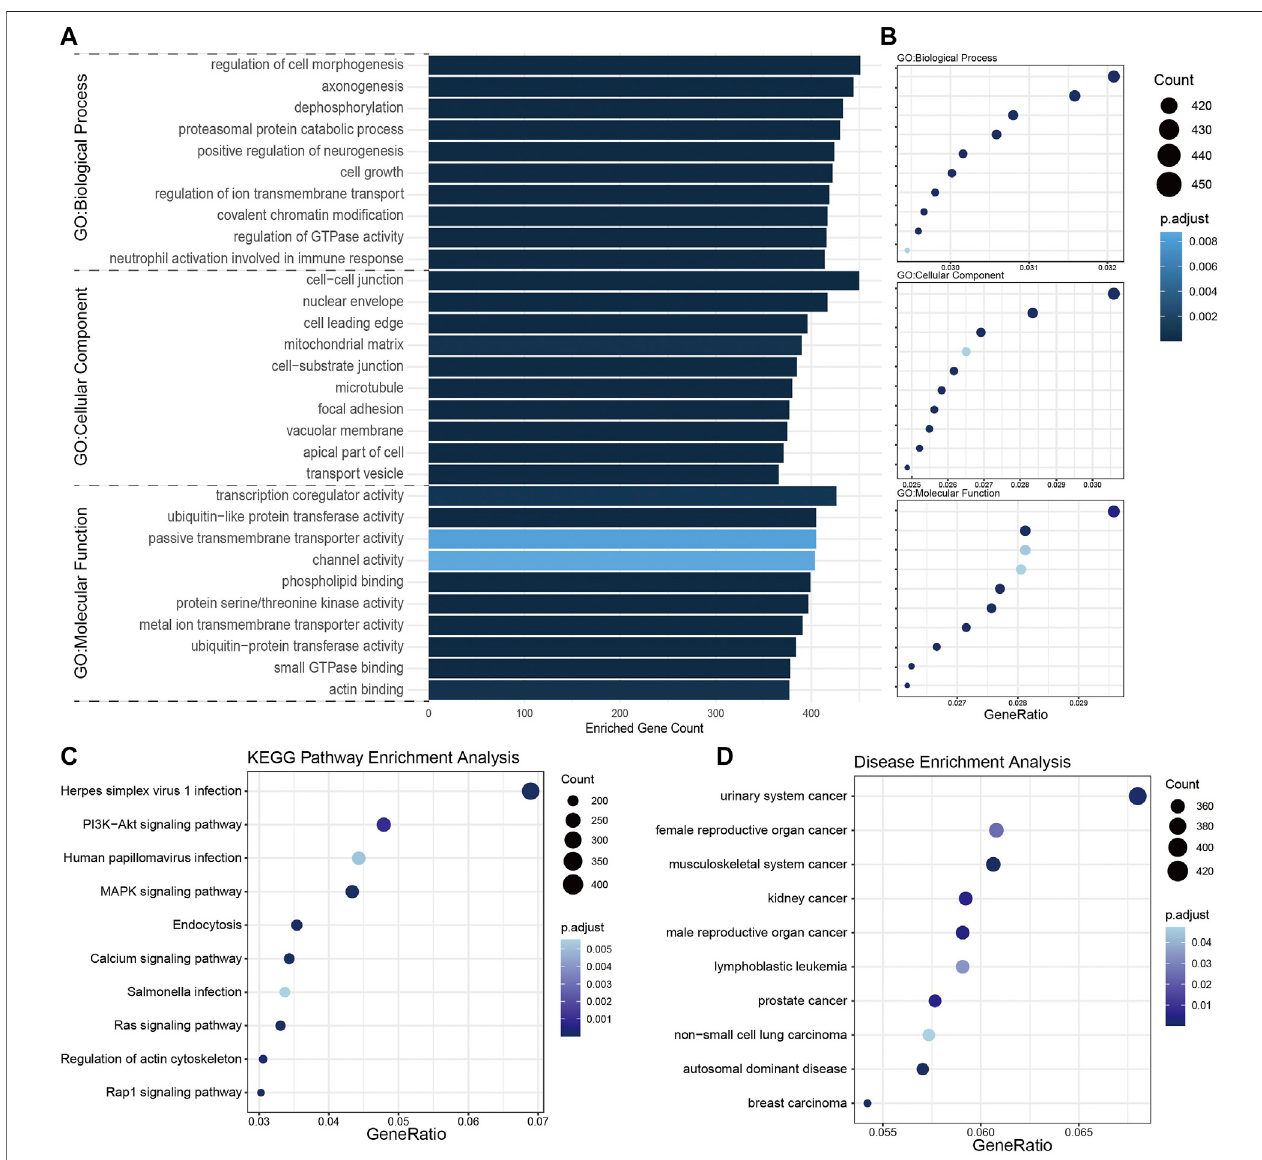
FIGURE 3 | Enrichment analysis of target transcripts of DE-miRNAs. (A,B) GO enrichment analysis showed the top 10 terms each in biological process, cellular component, and molecular function. (C) KEGG pathway enrichment analysis revealed target transcripts enriched in Herpes simplex virus 1 infection and PI3K-Akt signaling pathway. (D) Disease ontology (DO) enrichment analysis indicated these target transcripts mainly enriched in cancer-associated terms.